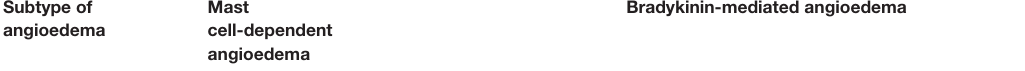
TABLE 2 | Differential diagnosis in patients with angioedema. Subtype of